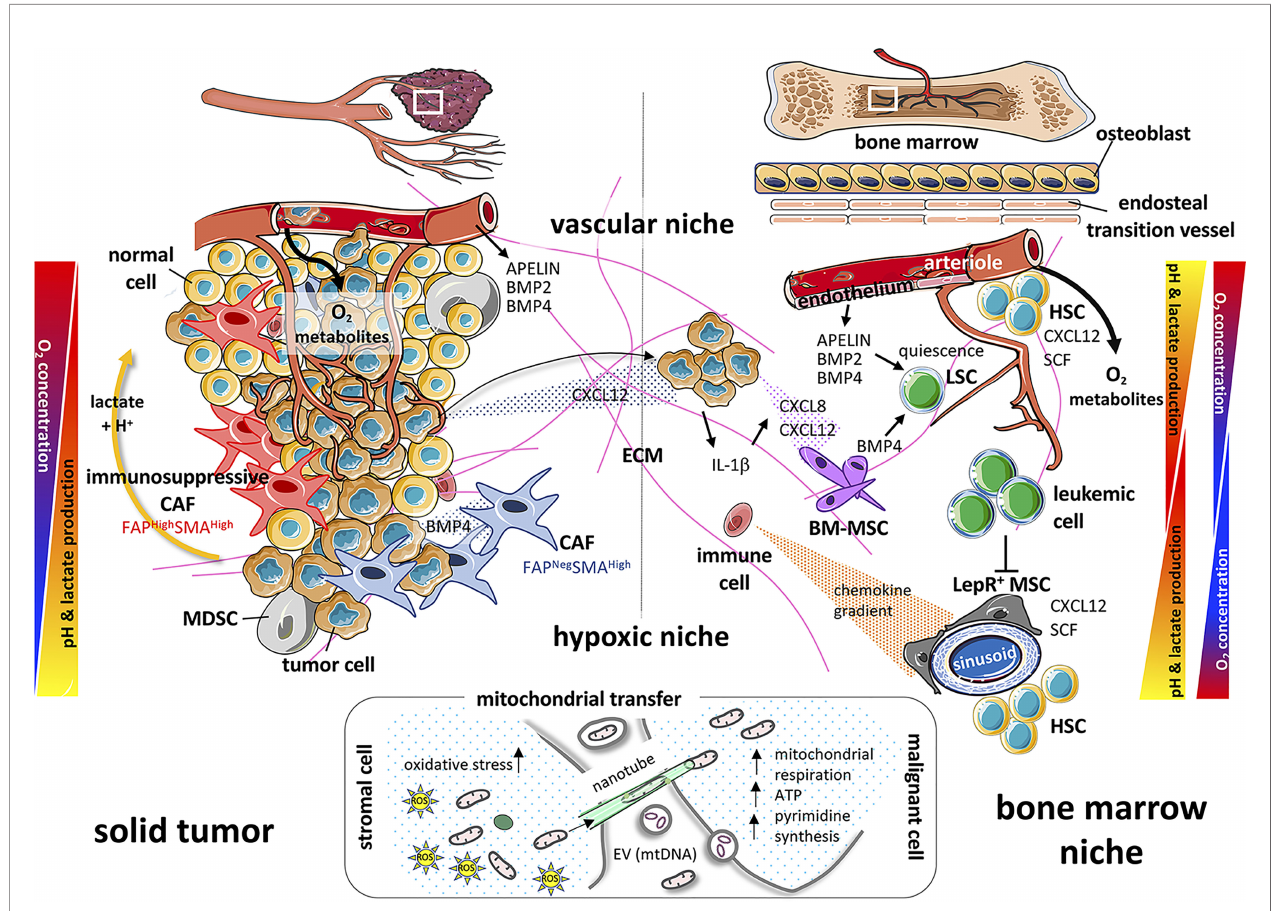
FIGURE 1 | Paralleling the microenvironment and actors of the solid tumor and bone marrow niche. On the left part of the diagram, the solid tumor is governed by cellular components such as healthy cells and tumor cells juxtaposed with immunosuppressive or neutral cancer-associated fi broblasts (CAFs) and myeloid-derived suppressor cells (MDSCs). The different gradients of oxygen, pH and growth factors (BMP2, BMP4), then participate in the tumor cell fate (proliferation, metastasis … ). On the right panel, healthy hematopoietic stem cells (HSCs), bone marrow-mesenchymal stem/stromal cells (BM-MSCs), immune cells and tumor cells (attracted from a solid tumor by chemokine gradients such as CXCL12) or leukemia cells, quiescent or not, will be confronted with gradients of oxygen, pH, growth factors (BMP2, BMP4, SCF, APELIN) and cytokines (CXCL8, CXCL12, IL-1 b ) in a similar way as cells within the solid tumor. All these interrelations and interconnections, controls and feedbacks, will allow the tumor cell to proliferate and spread. Oxygen gradients, on the left, result from diffusion of oxygen from the blood vessels (vascular niche) as tumors grow outward from the local vascular architecture. Vascular niche may also be a source of factors favoring tumor growth ( i.e Apelin) in solid tumor and in the bone marrow niche. On the right, there is a double gradient between arterioles and sinusoids. The cells will adapt their metabolism along these gradients and create, as a counterpart, a pH gradient due to the release of lactate and H + protons. Bottom part: As crucial powerhouses for cell metabolism and tissue survival, mitochondria will transfer horizontally from stromal cells to cancer and/or immune cells, via nanotubes, extracellular vesicles (EVs) or freely, to allow recipient cells to adapt and modify their metabolism (mitochondrial respiration, ATP, pyrimidine synthesis) to meet different stresses (oxidative stress) and energy